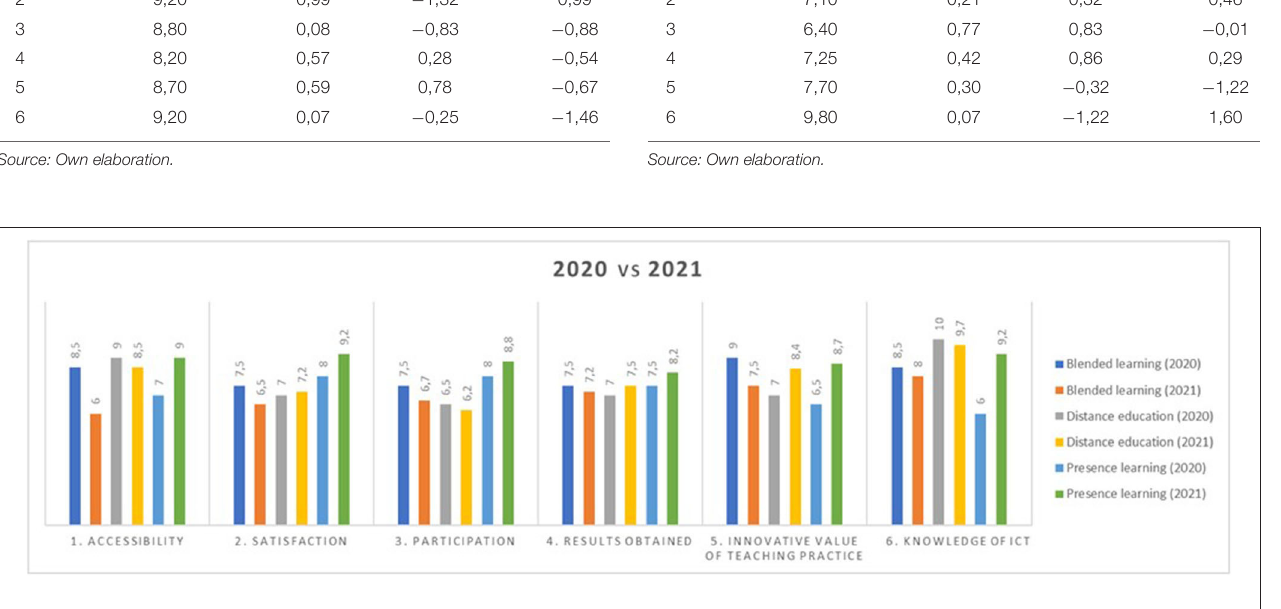
Frontiers in Psychology |